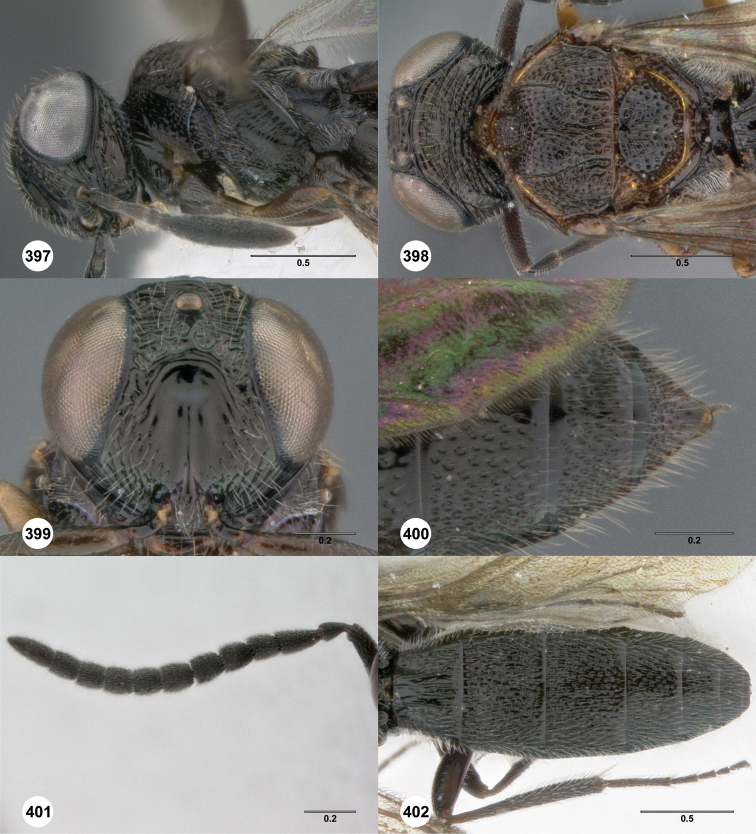
Oxyscelio verrucae sp. n., paratype female (OSUC 438819) 397 Head and mesosoma, lateral view 398 Head and mesosoma, dorsal view 399 Head, anterior view 400 Metasoma, dorsal view. Paratype male (OSUC 438825) 401 Antenna 402 Metasoma, dorsal view. Morphbank103